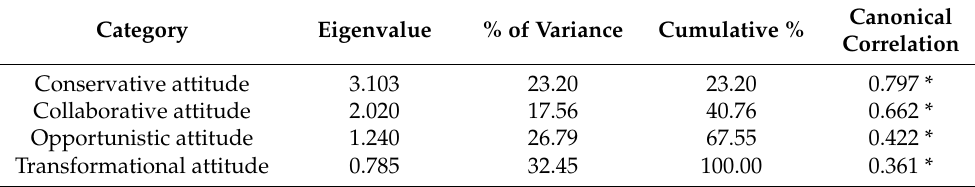
Table 6. Discriminant analysis.